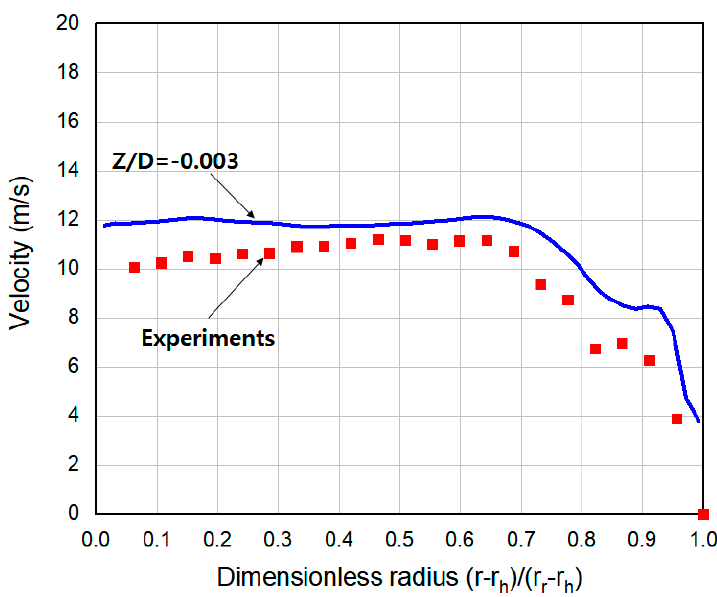
Figure 8. Velocity distributions at each section at y = 0 section in the upstream and comparison with experiments.